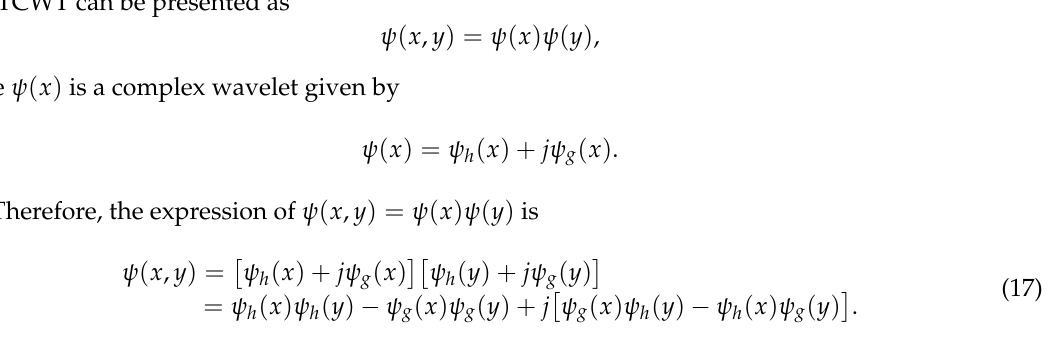
Real parts of DTCWT